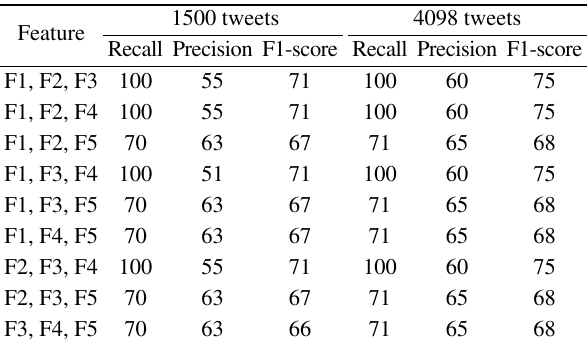
Table 8 Comparison of three different combinations of features in linear kernel.